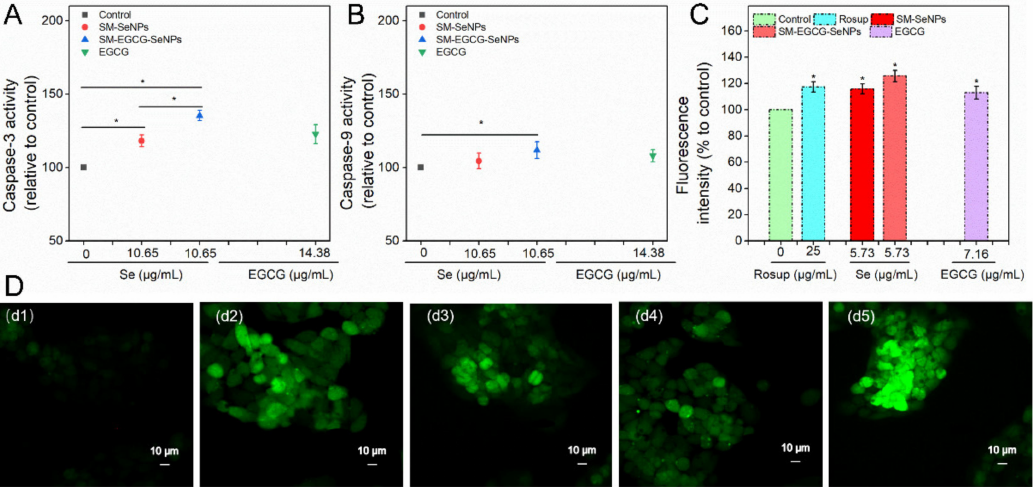
Figure 5. Activities of caspase-3 ( A ) and caspase-9 ( B ) in HepG2 cells in the SM-SeNP group, EGCG group, and SM-EGCG-SeNP group, respectively. ( C ) ROS analysis. ( D ) Confocal laser images of ROS production: (d1) blank, (d2) positive, (d3) SM-SeNPs, (d4) EGCG, and (d5) SM-EGCG-SeNPs. Each value represents the mean ± SD. The difference between groups is indicated at * p <